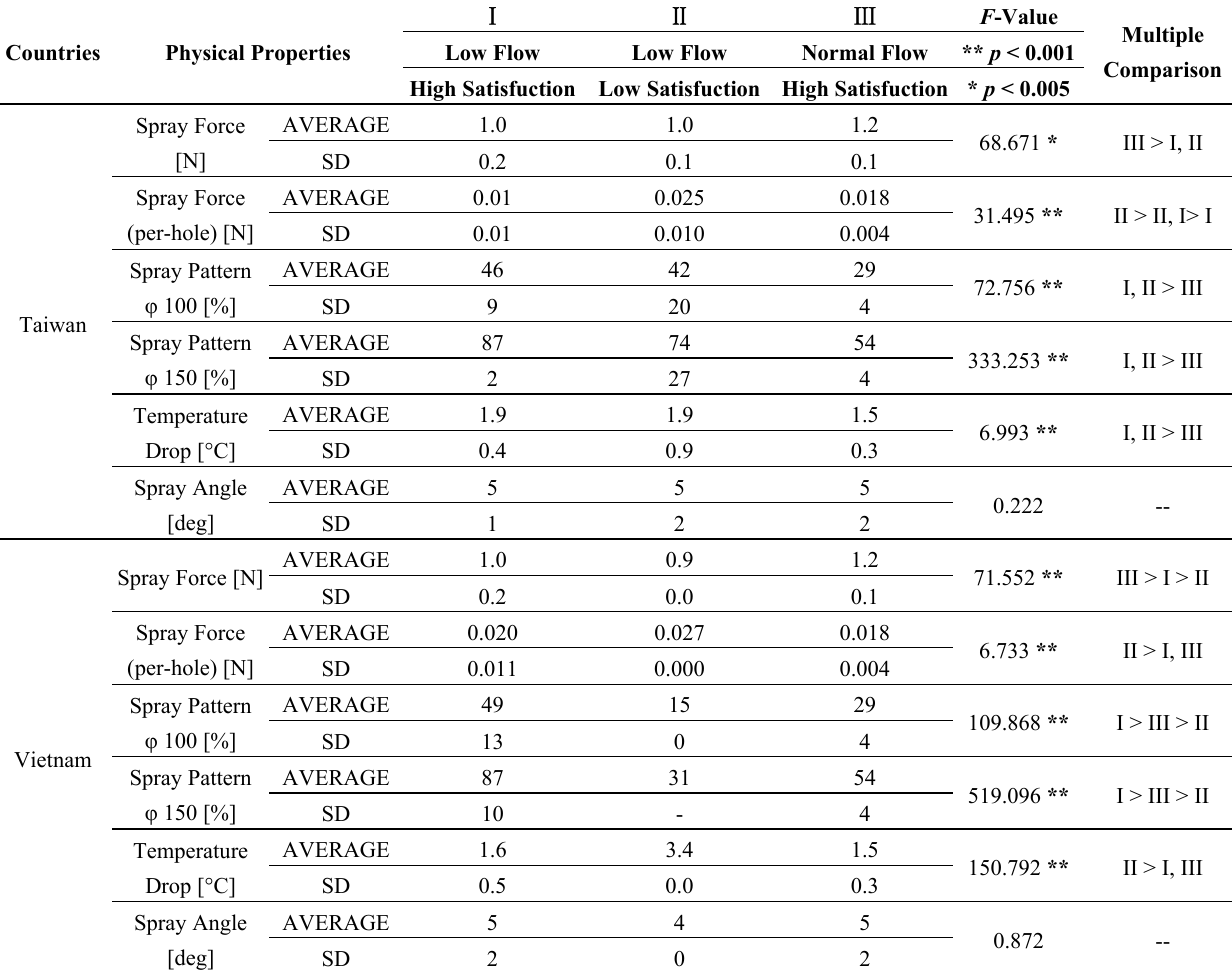
Table 4. Result of ANOVA and multiple comparisons (physical